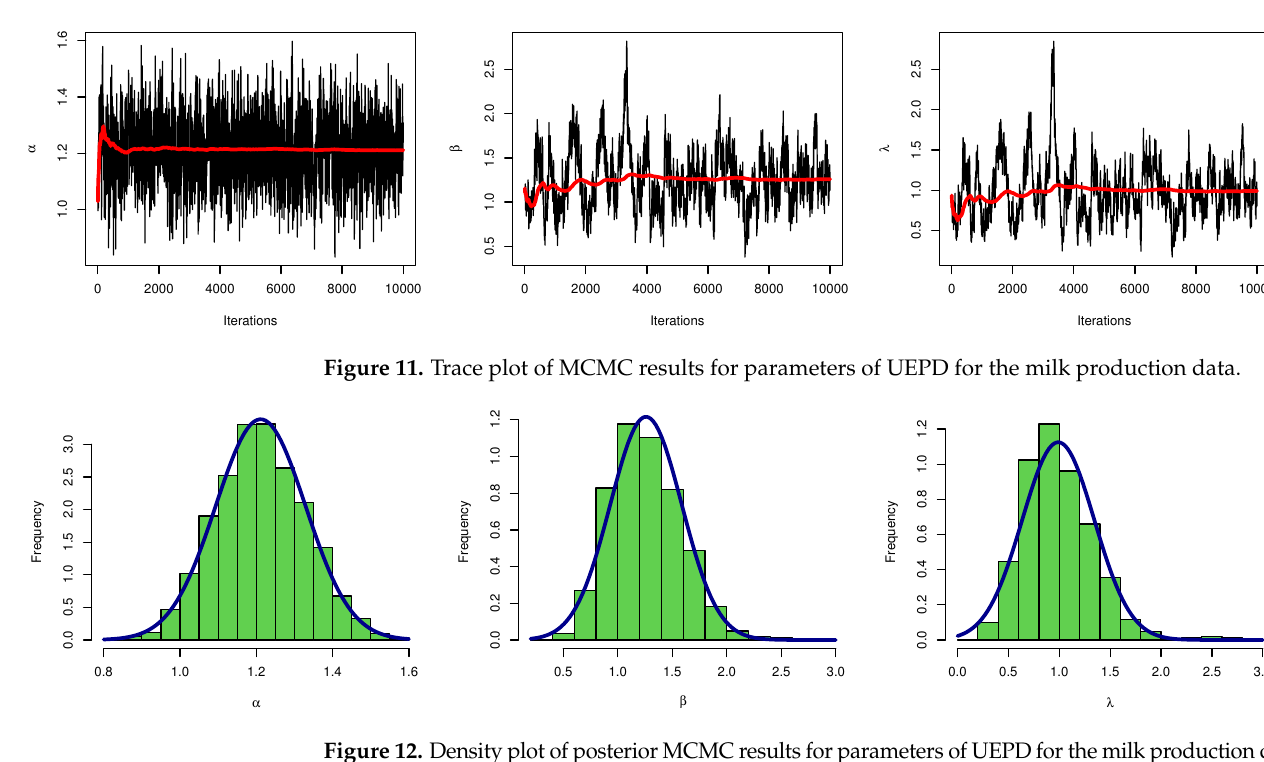
Figure 12. Density plot of posterior MCMC results for parameters of UEPD for the milk production data. Table 9. M L E , MPS p , Bayesian estimation methods for milk production data.